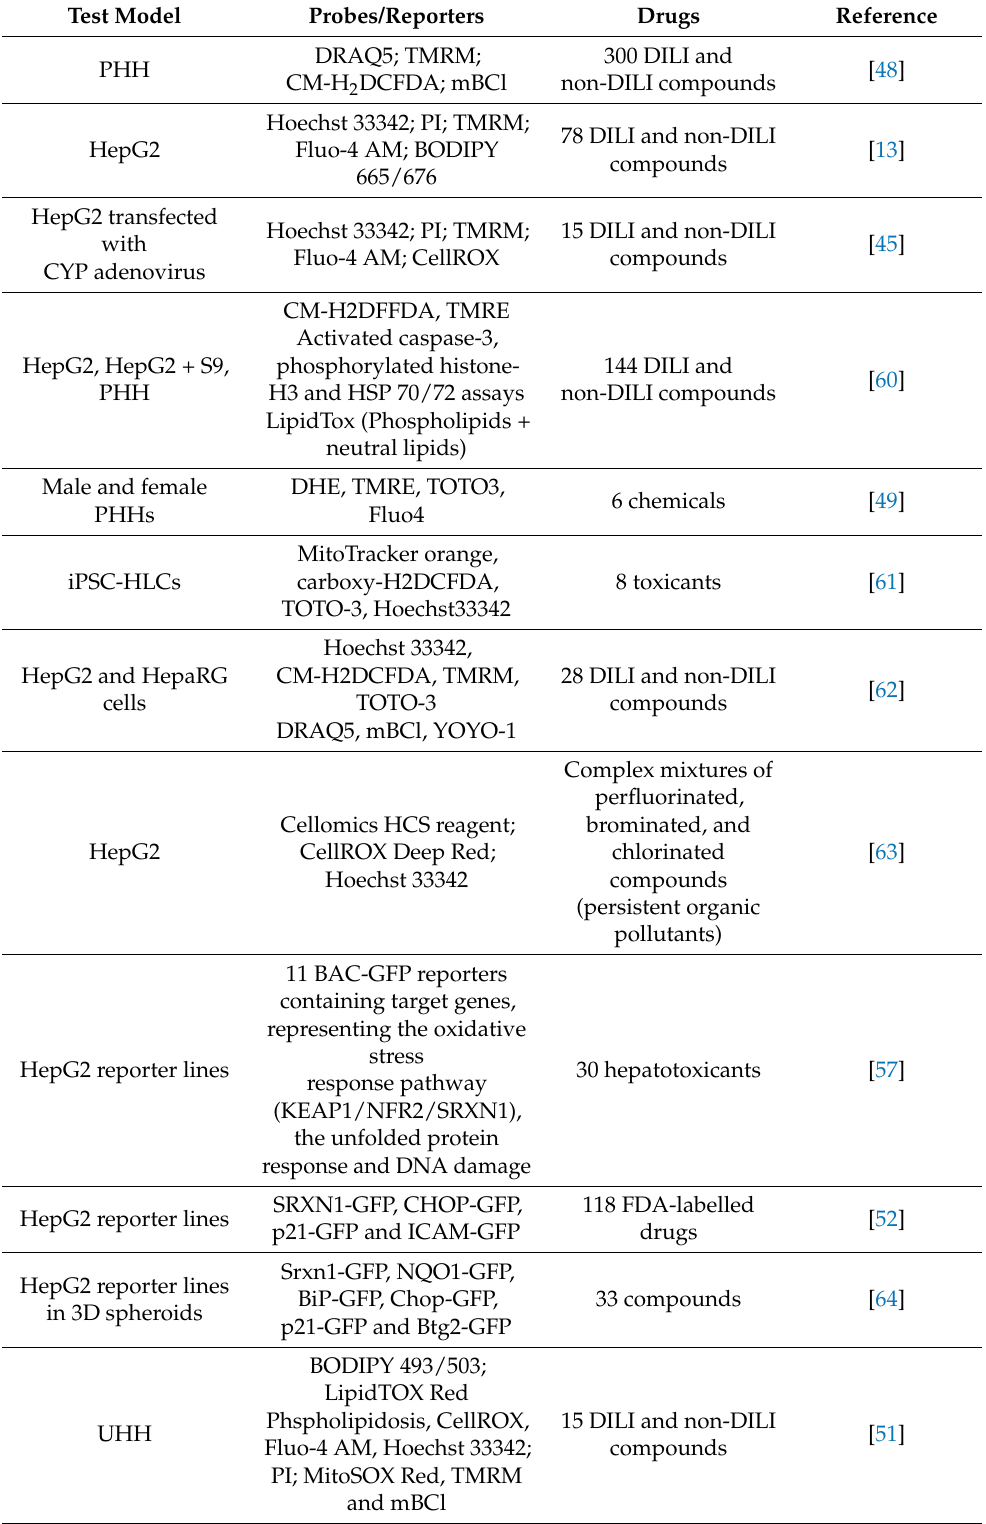
Table 3. HCS assays for the detection of oxidative stress-induced liver injury. DILI: drug-induced liver injury; HLCs: hepatocyte-like cells; iPSCs: induced pluripotent stem cells; PHH: primary human hepatocytes; UHH: Upcyte human